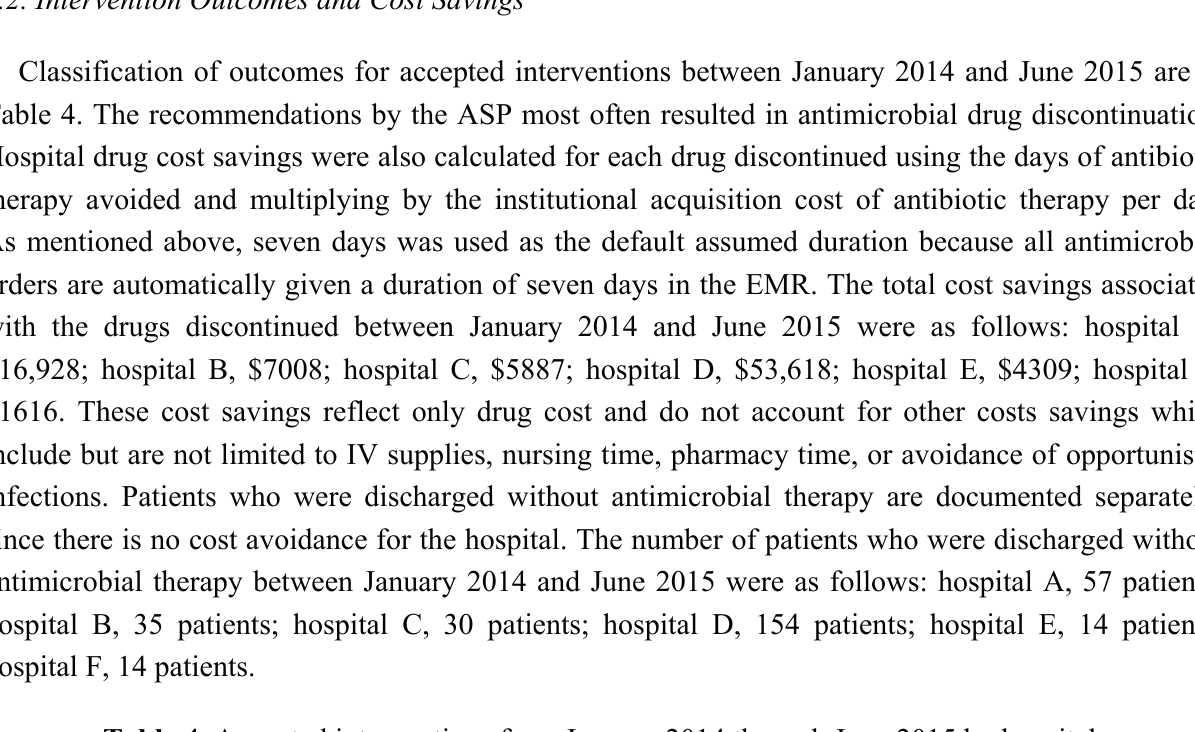
Table 4. Accepted interventions from January 2014 through June 2015 by hospital. Intervention (Number over Past 18